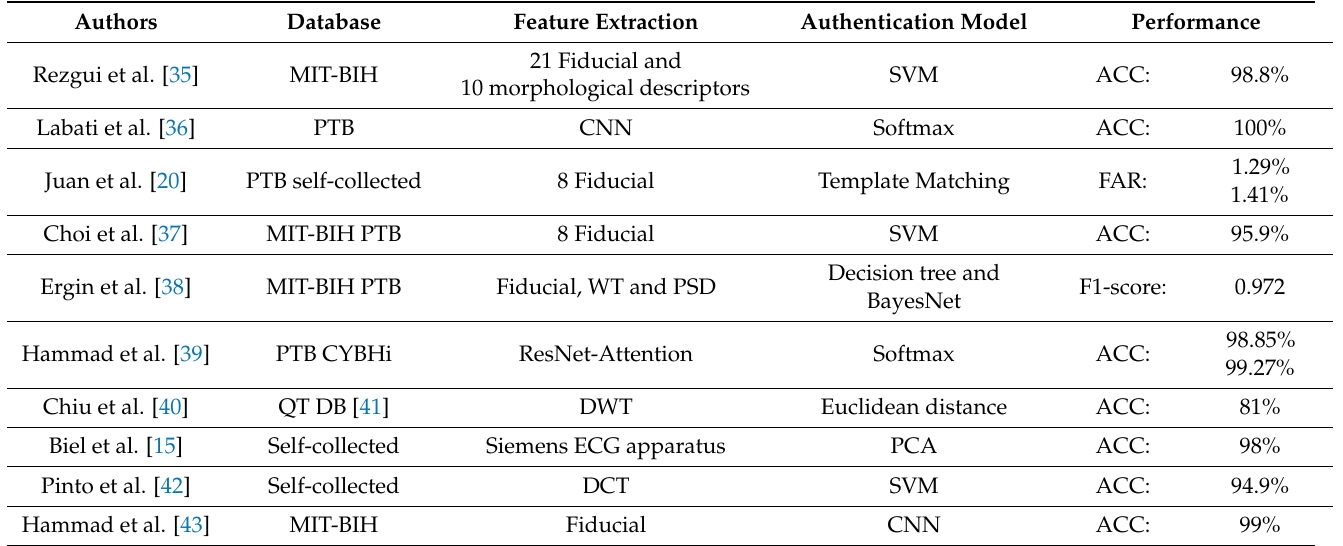
Table 1. Summary of the studies of the ECG-based authentication method. SVM—support vector machine, ACC—accuracy, CNN—convolutional neural network, DWT—discrete wavelet transform, FAR—false acceptance rate, PSD—power spectral density, DCT—discrete cosine transform, PCA—principal component